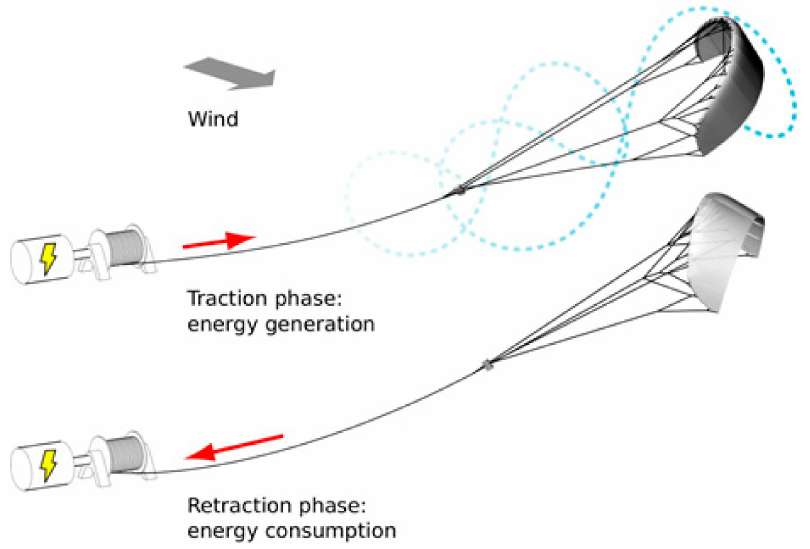
Figure 1. The pumping cycle of an airborne wind energy system consisting of a fixed ground station and a soft-wing kite flying crosswind maneuvers